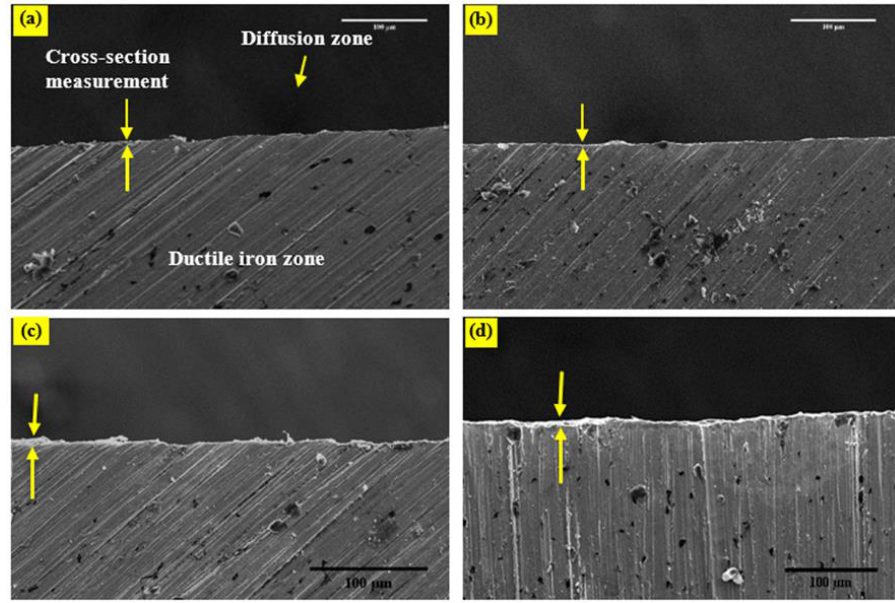
Figure 11: The thickness layer analysis by cross-section testing. (a) thickness layer of sample not using preheating process (S4), (b) thickness layer of the sample by using temperatur preheating 500°C (S1), (c) the thickness layer of the sample by using temperatur preheating 700°C (S2), (d) the thickness layer of the sample by using temperatur preheating 900°C